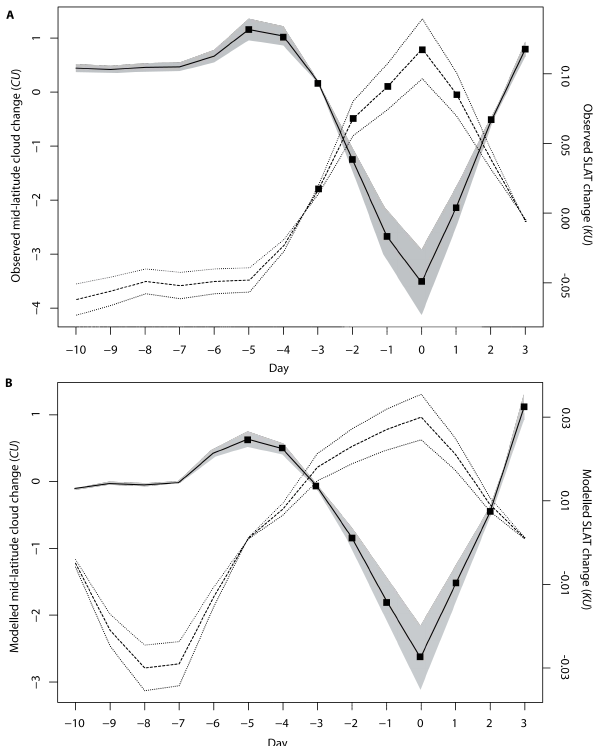
Fig. 5. Anomalous mid-latitude (60 ◦ –30 ◦ N/S) average tropo- spheric (30–1000mb) cloud cover changes (solid line) and surface level air temperature changes (dashed line) from (A) observations and (B) the HadAM3 GCM. Markers indicate statistically signifi- cant anomalies (above the 0.95 confidence level). Solid grey shade and dotted lines indicate the 0.95 level confidence intervals for mean cloud and air temperature changes, respectively.